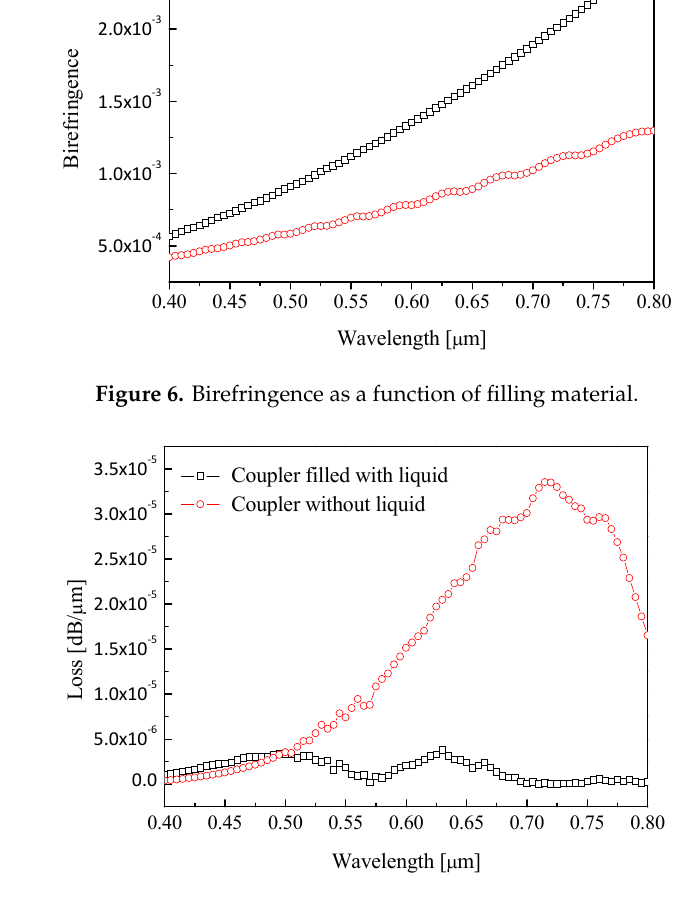
Figure 7. Confinement loss as a function of filling material.